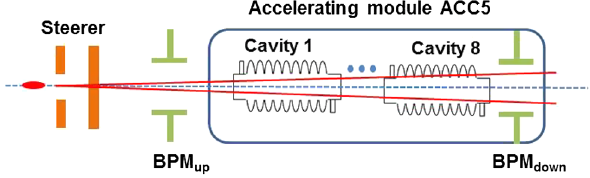
FIG. 5. Schematic drawing of the experimental setup used for the HOM-based beam position measurement in ACC5.